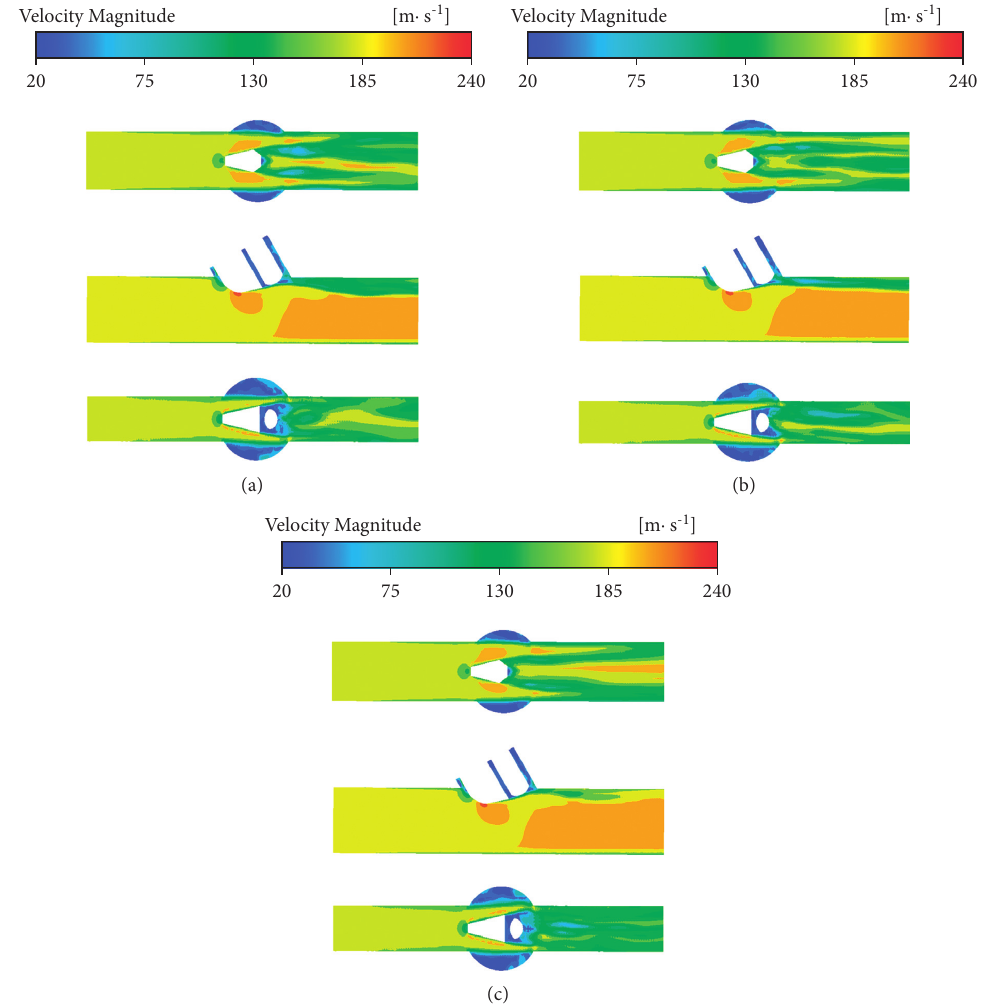
Figure 18: Velocity contour. (a) T � 7. (b) T � 10. (c) T �